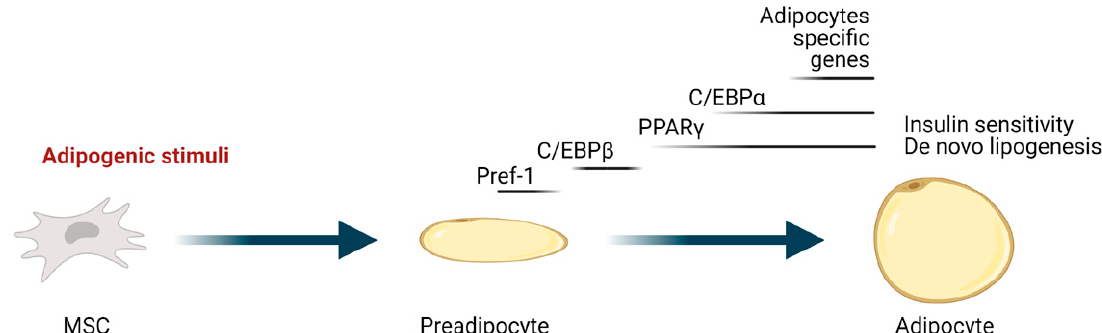
Figure 1. Transcriptional regulators of adipogenesis. Multipotent mesenchymal stem cells (MSC) upon adipogenic stimuli give rise to preadipocytes that, after clonal expansion and subsequent differentiation, become mature adipocytes. Molecules relevant in this process are shown with their approximate induction and duration reflected by lines. The preadipocyte factor 1 (Pref-1) is expressed in preadipocytes and participates in the maintenance of this state. It is an inhibitor of adipogenesis and its expression must be reduced during adipocyte differentiation. CCAAT-enhancer-binding protein C/EBP β is involved in adipogenesis at an early phase and, together with C/EBP δ , regulates the transcription of the peroxisome proliferator-activated receptor γ (PPAR γ ). PPAR γ with C/EBP α cooperatively induces adipocyte differentiation, regulating the expression of adipocyte-specific genes.